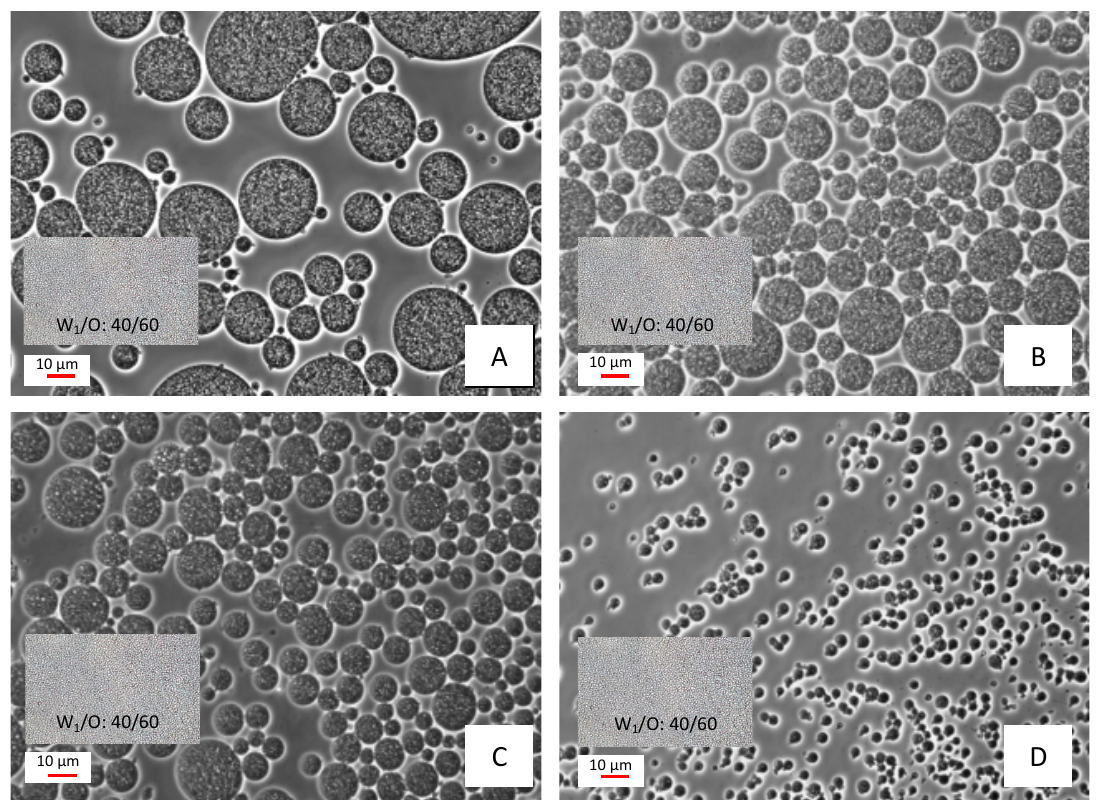
Figure 1. Morphology and size of the prepared double emulsions: 20/80 ( A ), 30/70 ( B ), 40/60 ( C ), and 50/50 ( D ) formulations. Each image includes a detail of the 40/60 primary emulsion using the same magnification; 400× magnification. Table 1. Creaming index evolution along 20 days for the tested formulations (20/80, 30/70, 40/60, and 50/50).